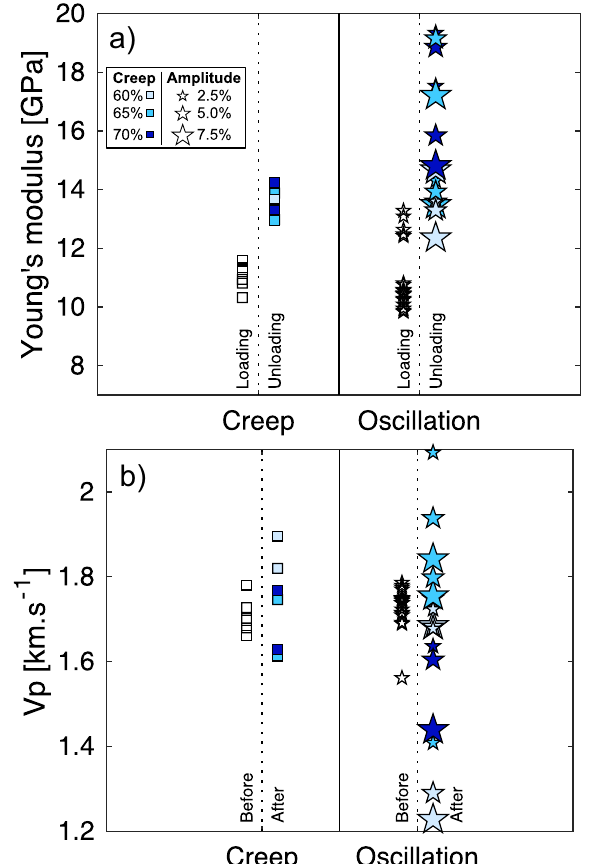
Figure 6. Changes in Young’s modulus and P-wave velocity (Vp) before and after the creep period. ( a ) Young’s modulus during the loading phase (hollow symbols) and unloading phase of creep (squares) and oscillation (stars) tests. ( b ) Ultrasonic velocities, Vp, estimated in pre-test samples (hollow symbols) and post-test samples deformed in creep (squares) and oscillation (stars) tests. For both creep and oscillation tests, the different shades of blue correspond to different stresses at each creep condition (the darker the shade, the higher the stress). For oscillation tests, the size of the star depicts the amplitude of the stress oscillation, with small stars corresponding to ± 2.5%, intermediate to ± 5%, and large to ± 7.5% of the creep stress